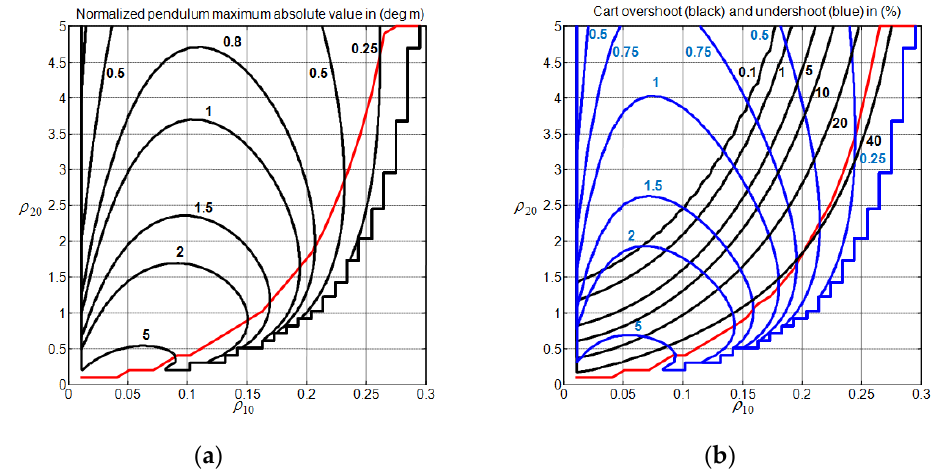
Figure 6. CIP control performance GM min = 1.63. ( a ) Normalized pendulum maximum absolute value index; ( b ) cart overshoot and undershoot indices.